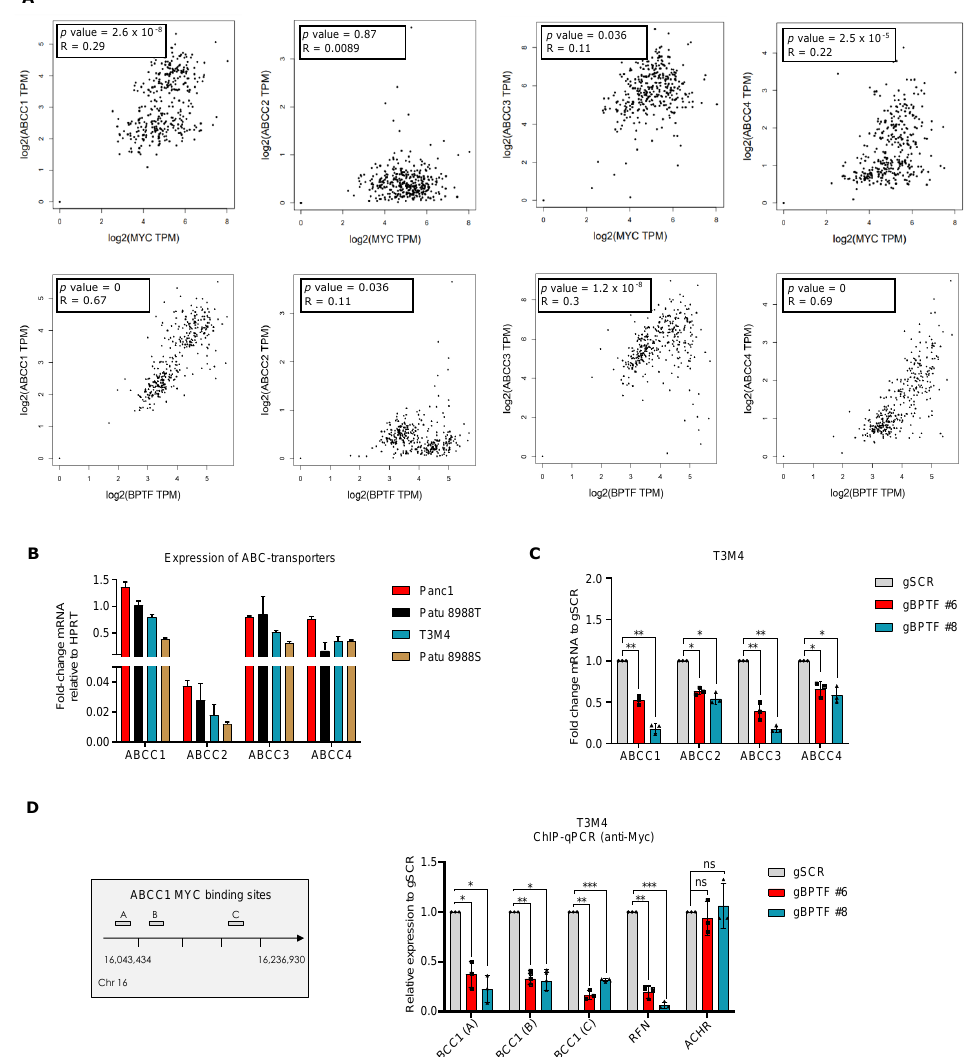
Figure 5. BPTF regulates the expression of several ABC-transporters. ( A ) Correlation between c- MYC, BPTF levels, and ABC-transporters ’ expression using data obtained from Gene Expression Profiling Interactive Analysis (GEPIA). ( B ) qRT-PCR for ABCC1, ABCC2, ABCC3, and ABCC4 in a panel of four human PDA cell lines. ( C ) qRT-PCR for ABCC1, ABCC2, ABCC3, and ABCC4 of BPTF- interfered cells (gBPTF #6 and gBPTF #8) compared to non-targeted (gSCR); n = 3. ( D ) Chromatin immunoprecipitation of c-MYC on the ABCC1 promoter in BPTF-interfered cells (gBPTF #6 and gBPTF #8) compared to non-targeted (gSCR); n = 3. Significance was considered for * p < 0.05, ** p < 0.01, *** p < 0.005, ns (not statistically significant).